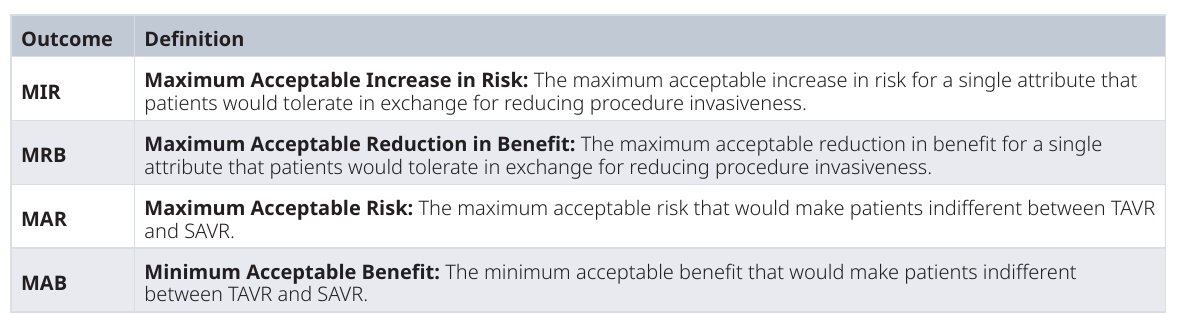
Table 3. Benefit-risk analysis